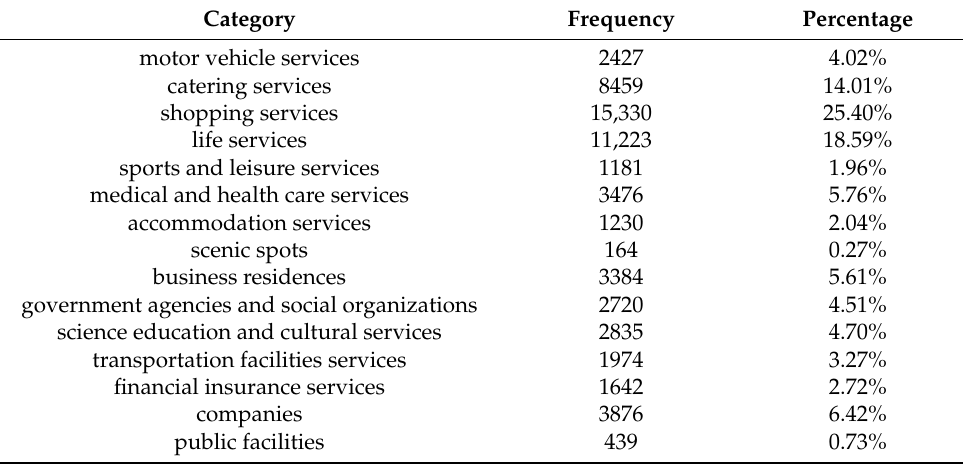
Table 1. Descriptive statistics of